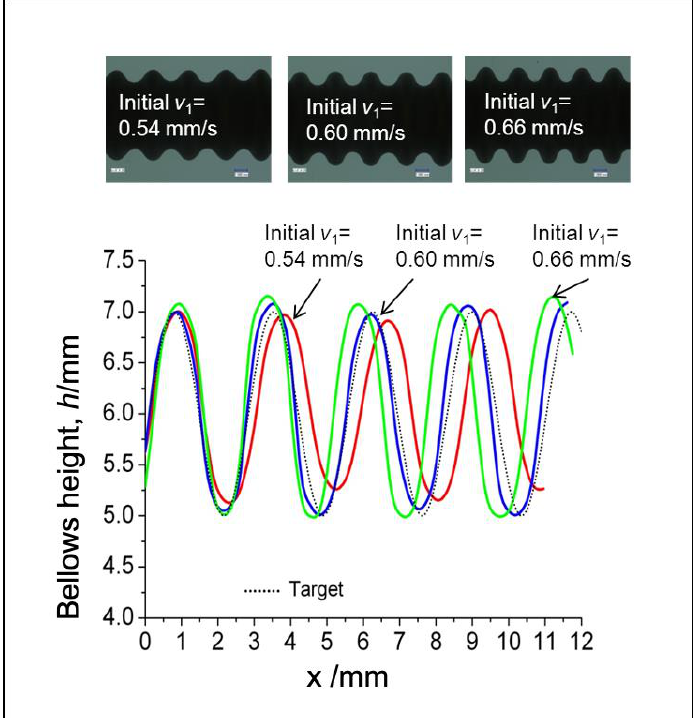
Figure 25. Bellows profile at different initial compression ratios.